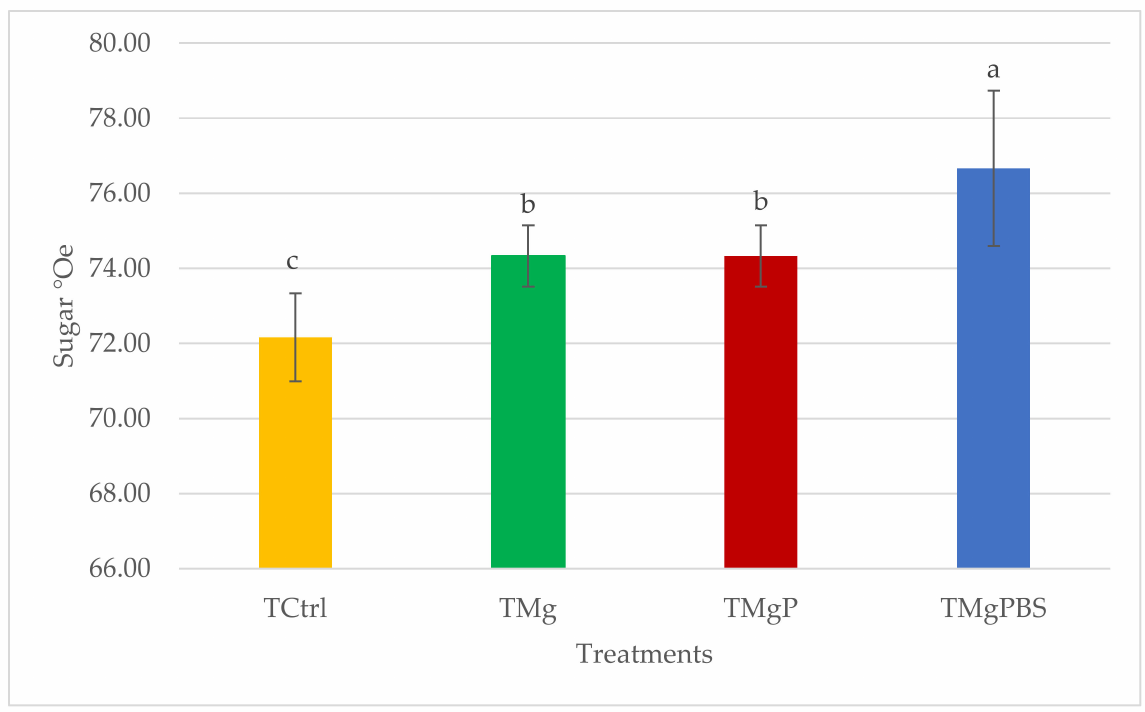
Figure 8. Must sugar by treatment. (TCtrl—NPK, TMg—NPK + Agromag (6% MgO), TMgP—NPK + Agromag + Fosforo (30% P 2 O 5 ) and TMgPBS—NPK + Agromag + Fosforo + Bio Prot). Bars with no common letters are significantly different according to Tukey’s HSD test ( p ≤ 0.05), Error bars indicate standard deviation ( n =